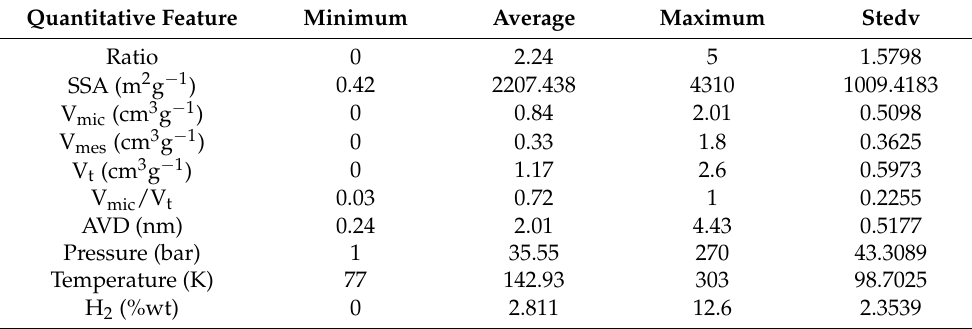
Table 5. The statistical criteria of input features for hydrogen storage in porous